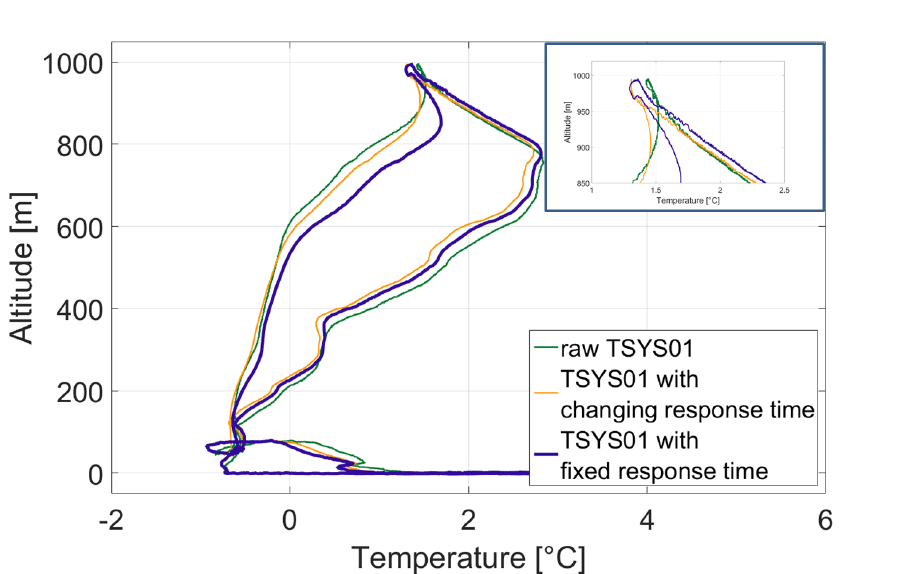
Figure 7. Reconstruction of the temperature signal of the raw slow TSYS01 sensor measurements (green) by applying constant (purple) and variable (yellow) response times, depending on the flow velocity. The line with lower temperatures corresponds to the